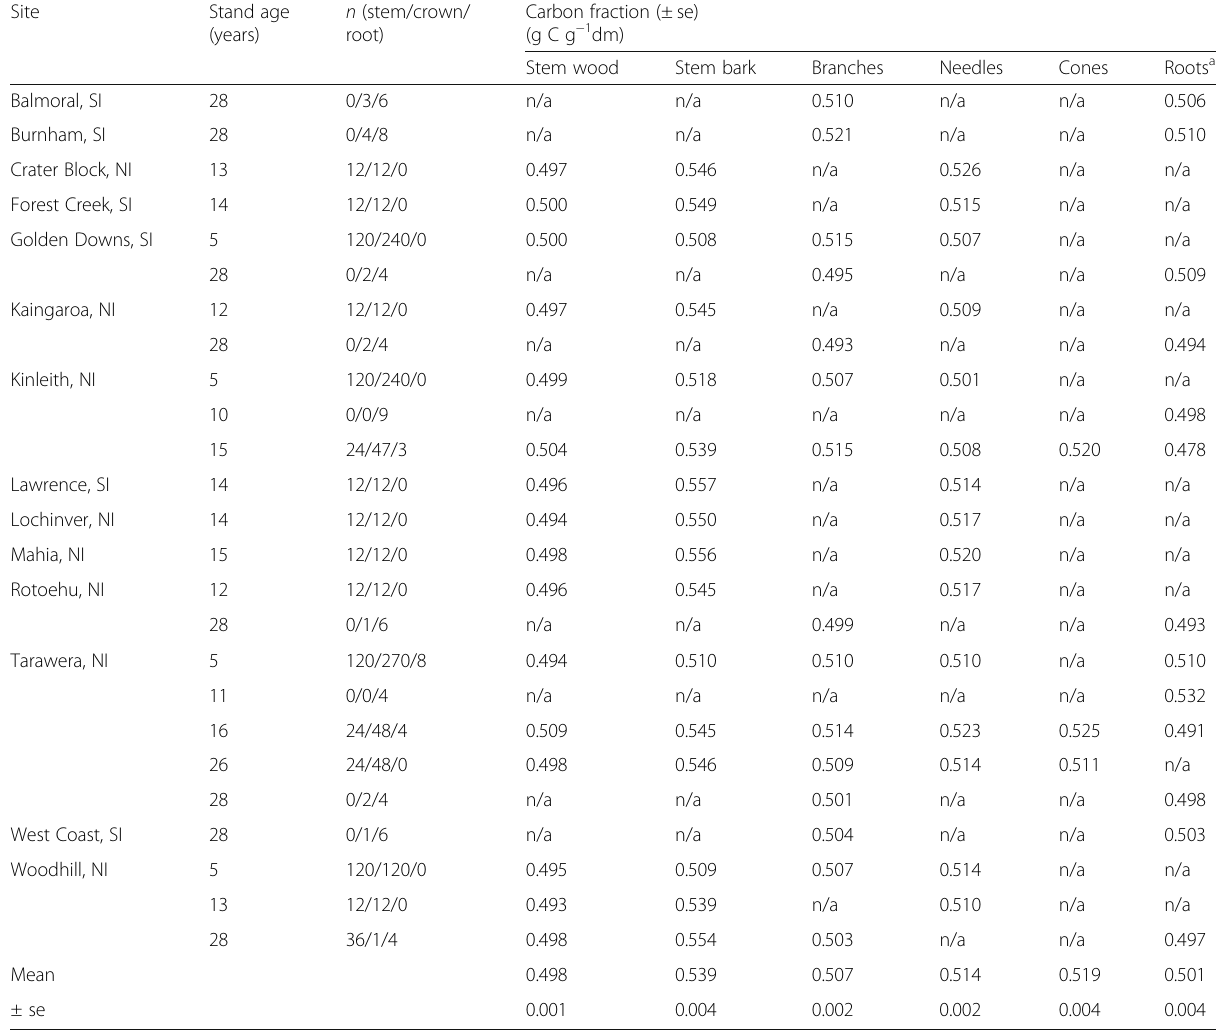
Table 1 Mean carbon fraction of radiata pine biomass components, age of sample stand, number of stems/crowns/roots